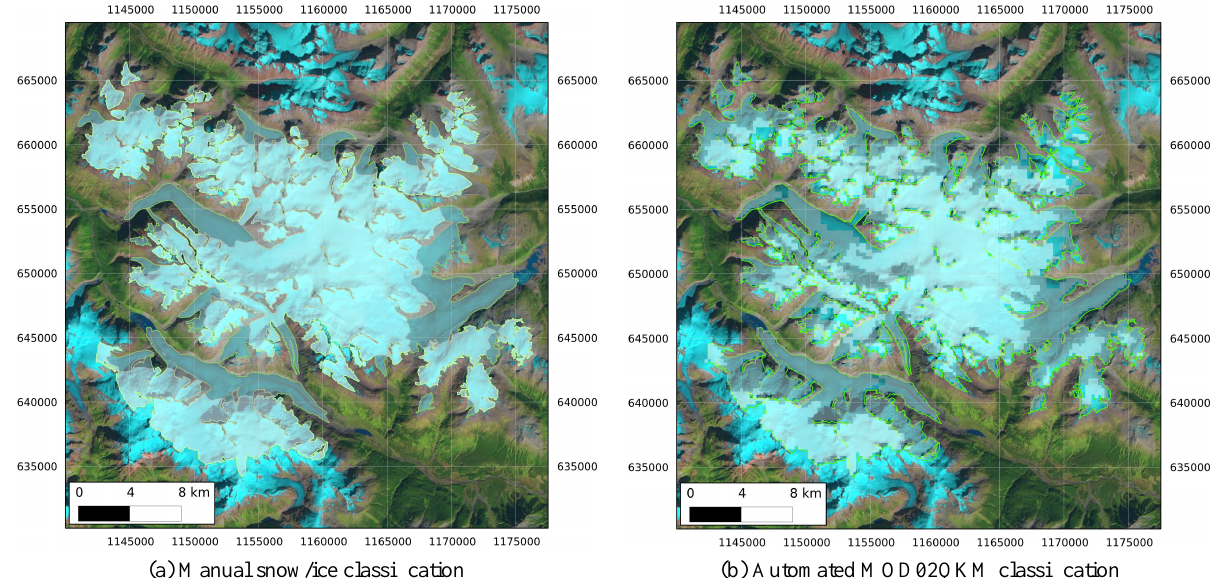
Fig. 8. Landsat 5 scene of the Lillooet Icefield and Bridge Glacier, 4 October, with (a) manual classification, and (b) MOD02QKM automated classification of snow (white) and ice (grey).